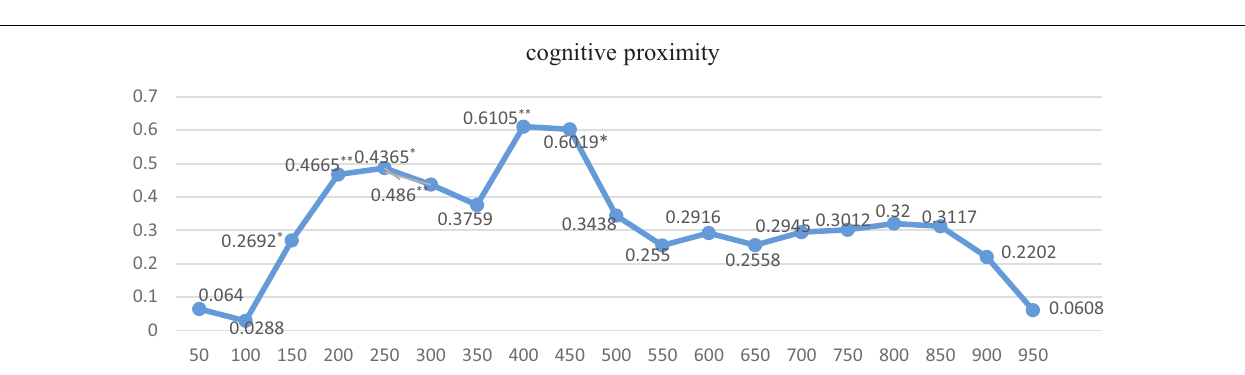
when geographical proximity intersects with social